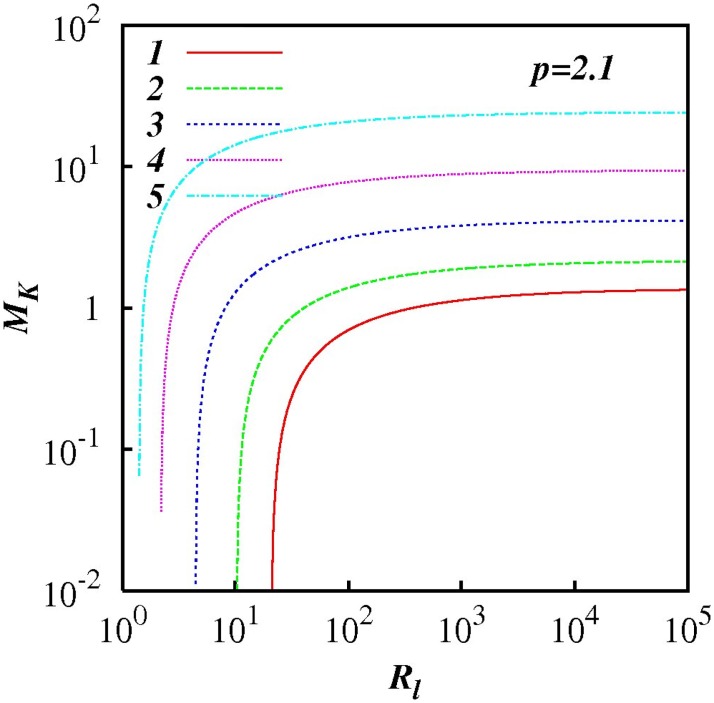
Similar to Fig 7, except for p = 2.1.